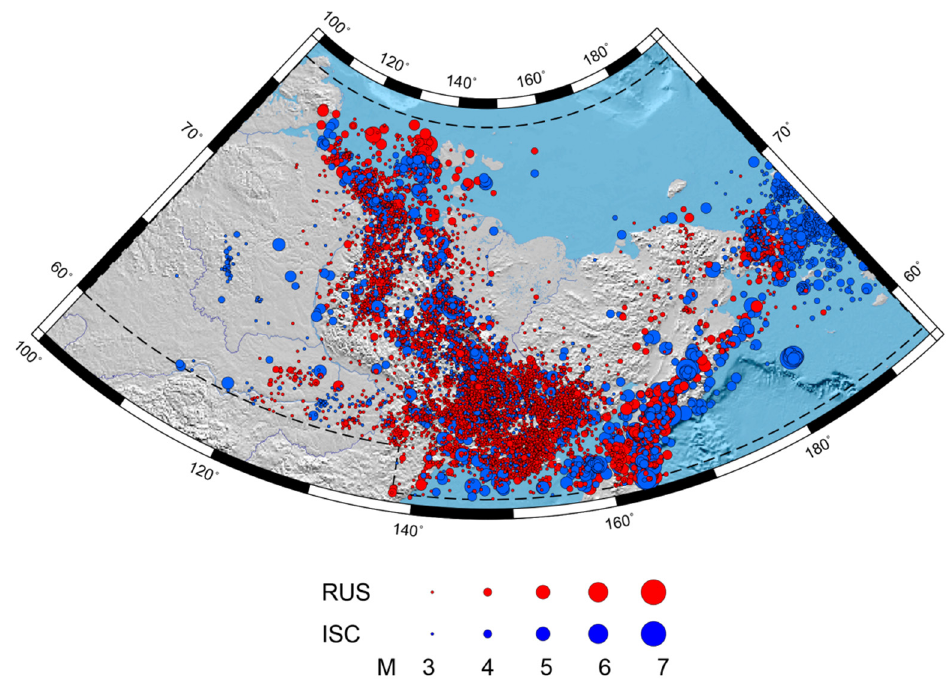
Figure 21. Map of earthquake epicenters of the integrated catalog of the Eastern Sector of the Arctic zone of the Russian Federation. The red and blue circles are the epicenters from the catalogs of GS RAS and ISC, respectively.